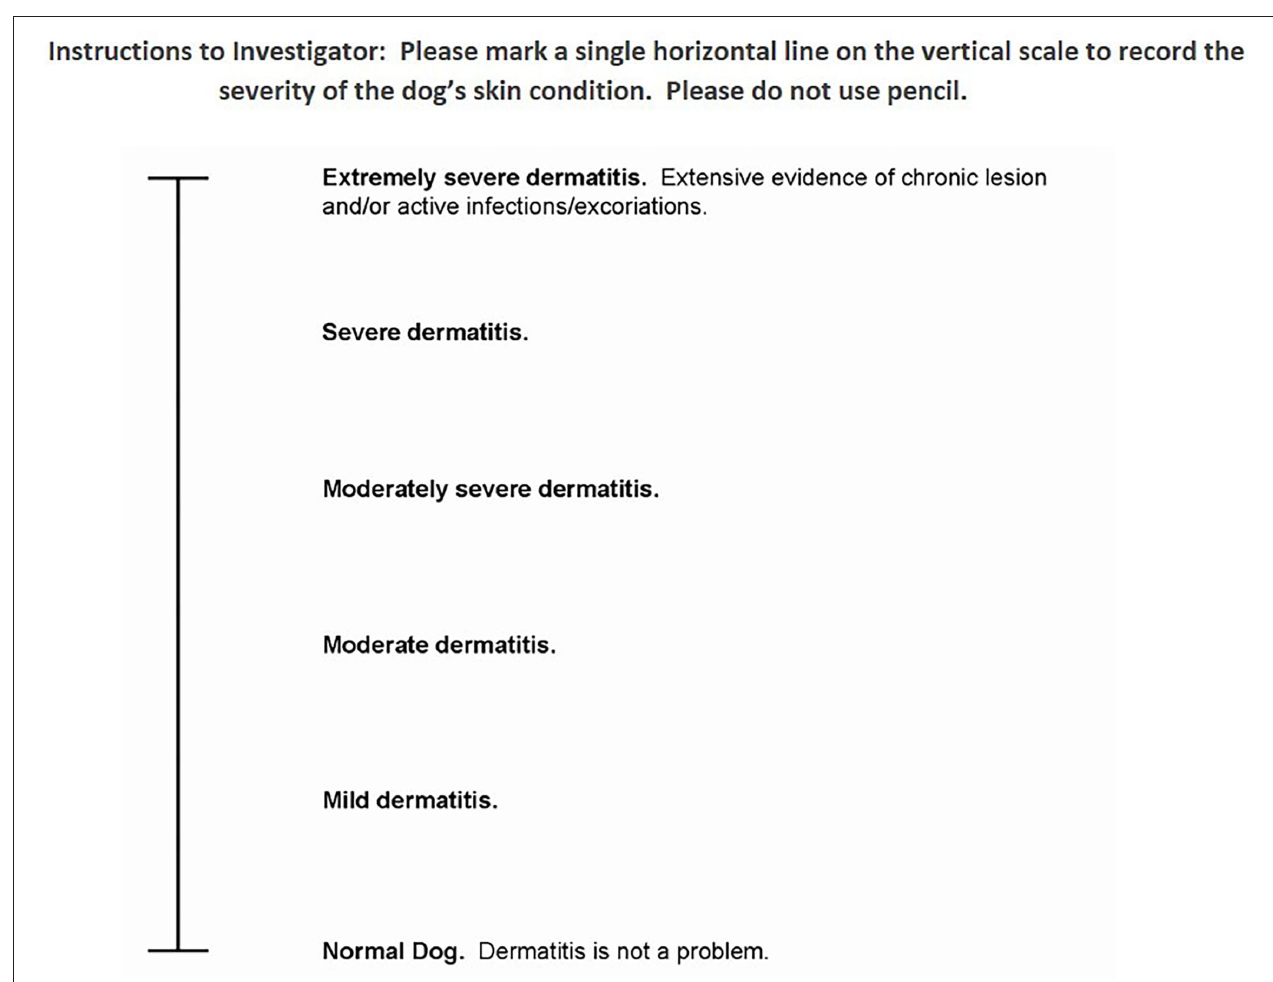
FIGURE 1 | Investigator visual analog score